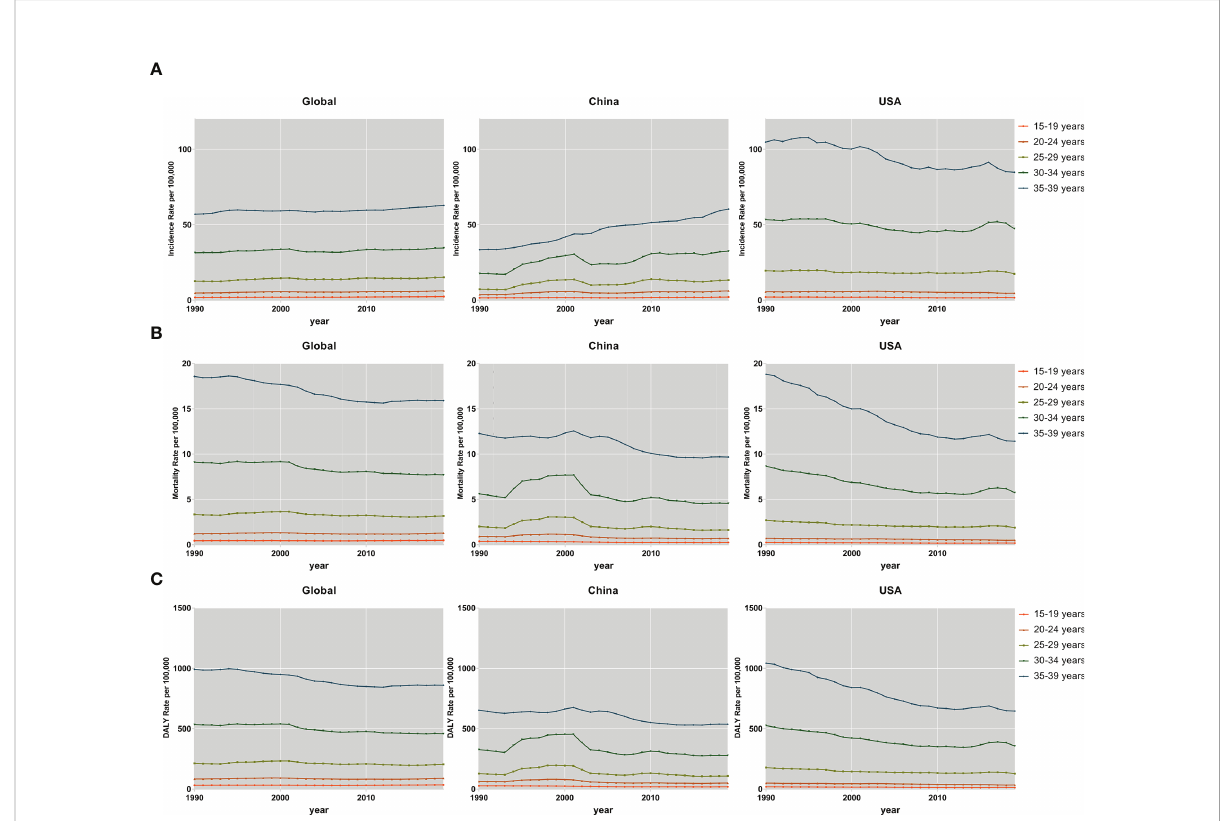
FIGURE 3 The incidence, mortality, and DALY rates of FeBGCs among AYAs. The incidence (A) , mortality (B) , and DALY (C) rates of female breast and gynecologic cancers among AYAs in the globe, USA, and China, from 1990 to 2019. AYAs, adolescents and young adults; DALY, disability- adjusted life years; FeBGCs, female breast and gynecologic cancers; USA, the United States of